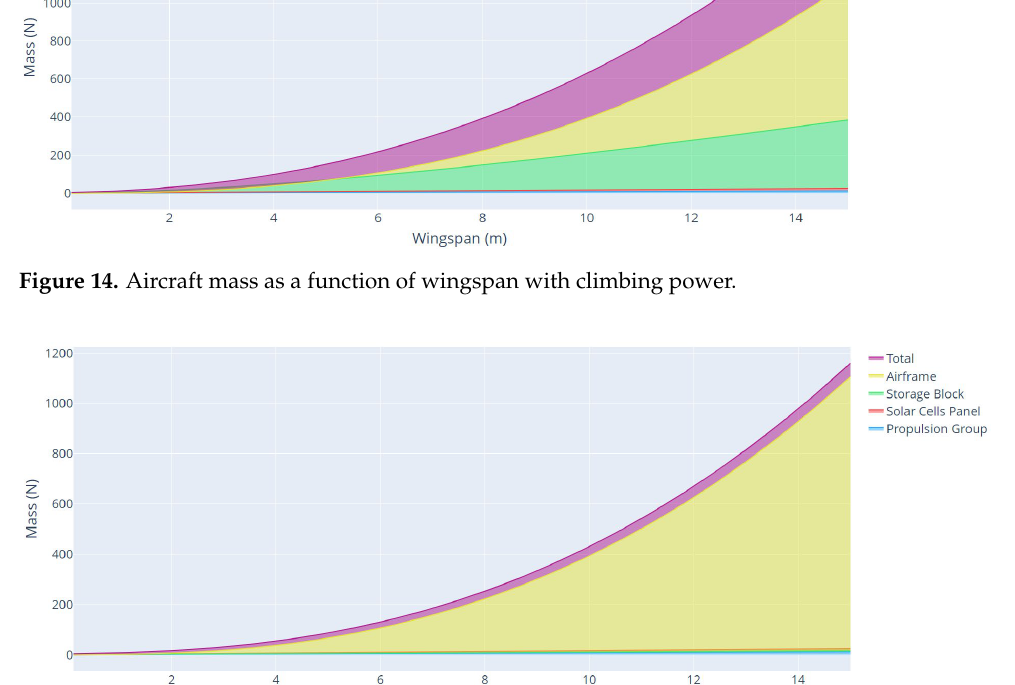
Table 7. Mission parameters for proposed